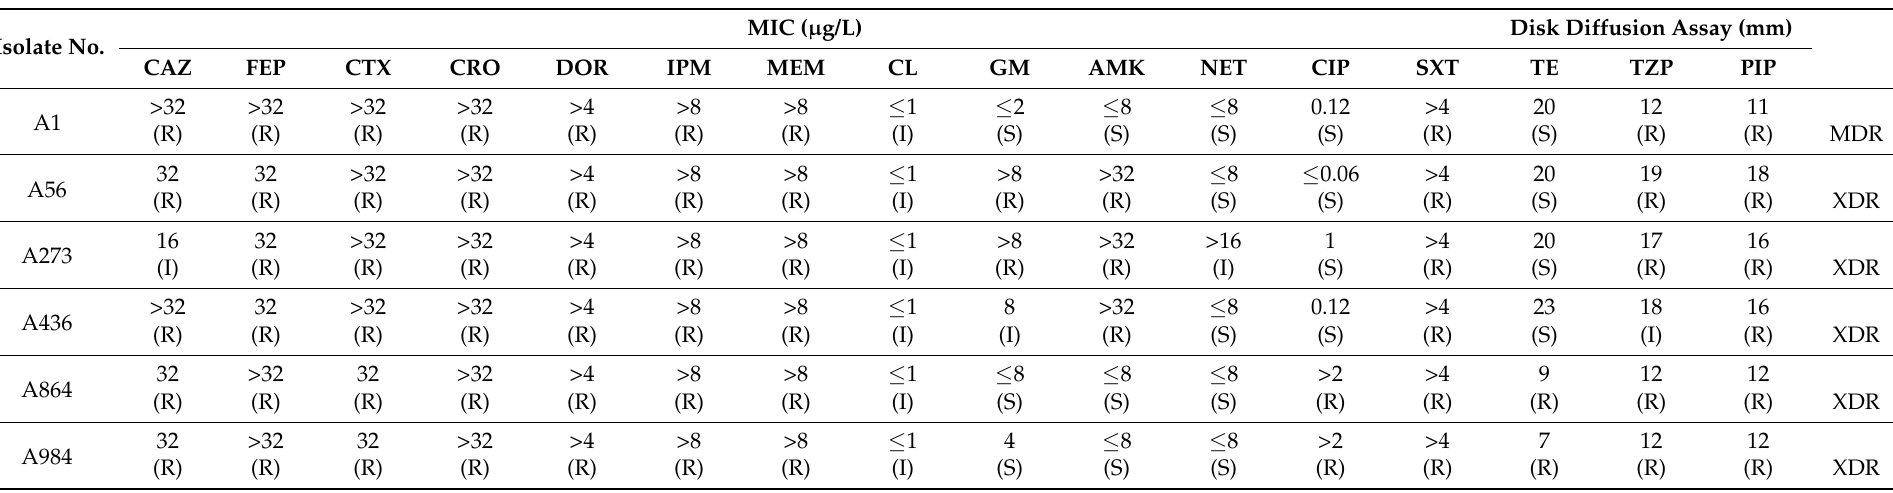
Table 2. Antimicrobial susceptibility profiles of carbapenem resistant A. pittii